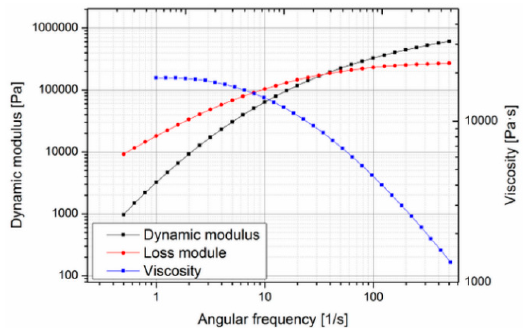
Figure 2. Rheological behavior of Purasorb copolymer of D -lysine-lactide and glycolide PDLG 5010 at 140 ° C.